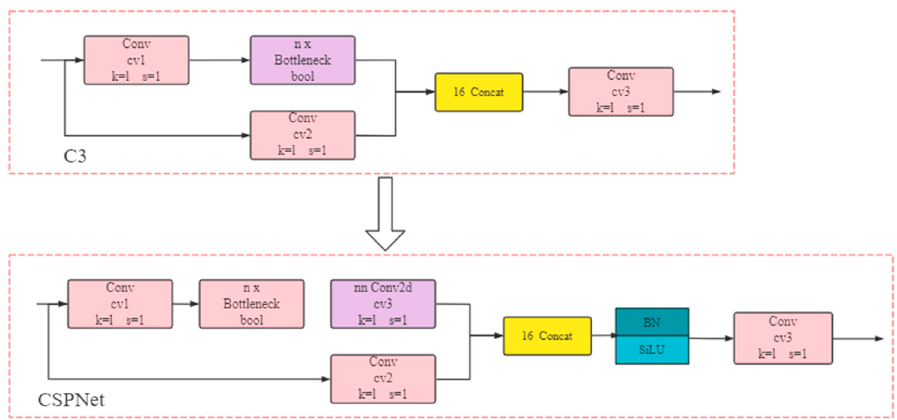
Figure 5. Schematic diagram of the component replacement. Note: The C3 component replaces the CSPNet component.